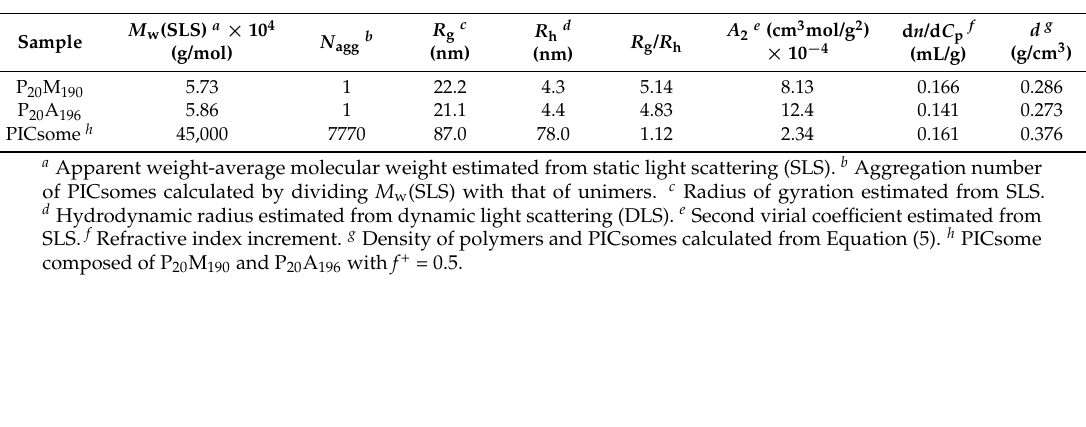
Table 2. Dynamic and static light scattering data for P 20 M 190 , P 20 A 196 , and polyion complex vesicles